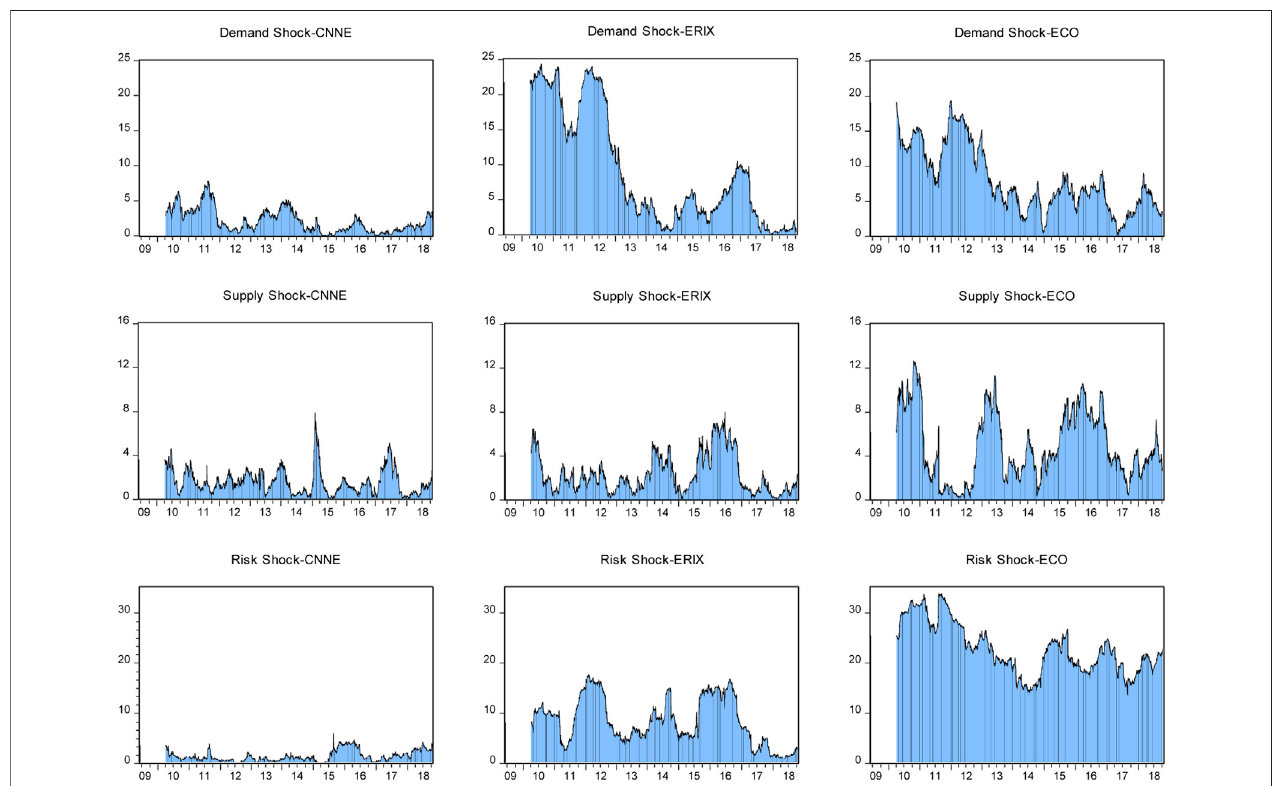
FIGURE 4 | Dynamic directional connectedness from oil shocks to new energy returns.